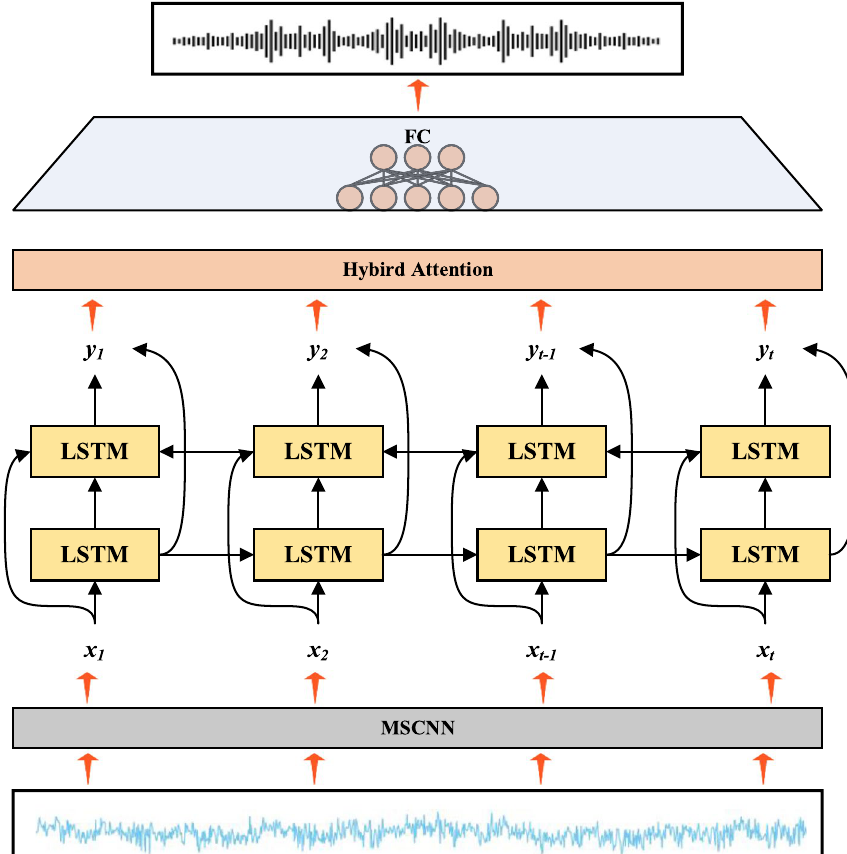
Fig. 9 The HATT-CNN-BiLSTM model and its